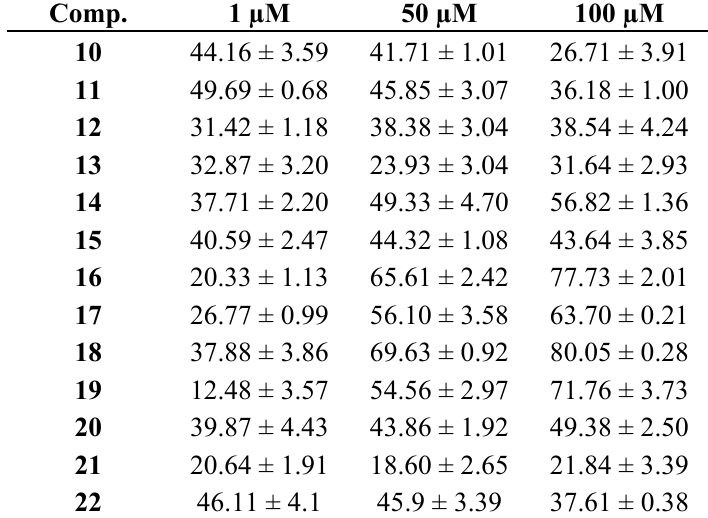
Table 1. Inhibitory effects (%) a of compounds 10 – 22 on K562 cell viability (mean ± SD; n = 4).